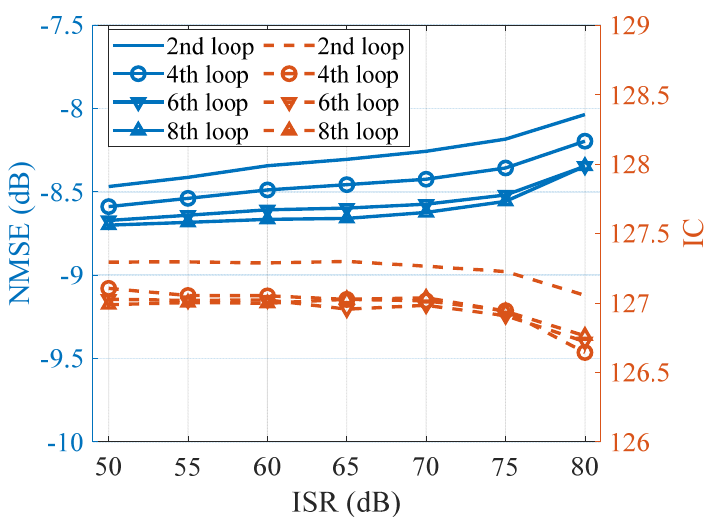
Figure 26. NMSEs and ICs of the target images obtained at the different loops of the proposed method under different ISRs with random WBI parameters.